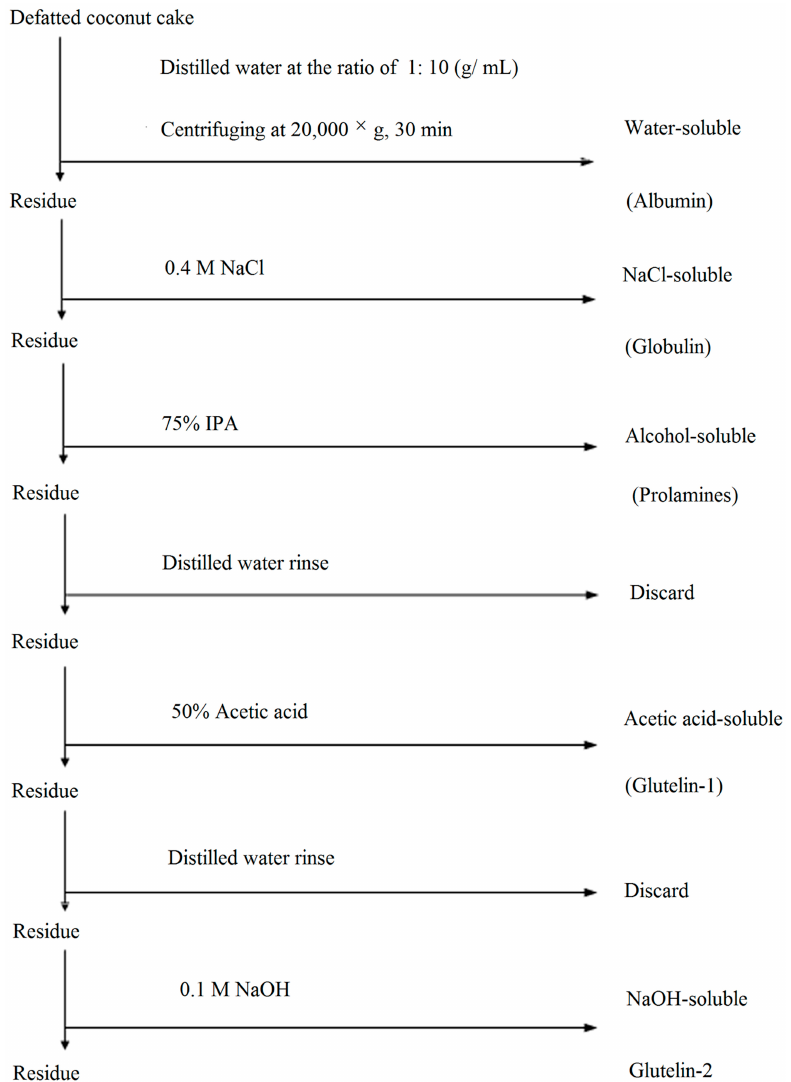
Figure 3. Flow sheet of the protocol used for fractionation of coconut cake protein by different solubility.